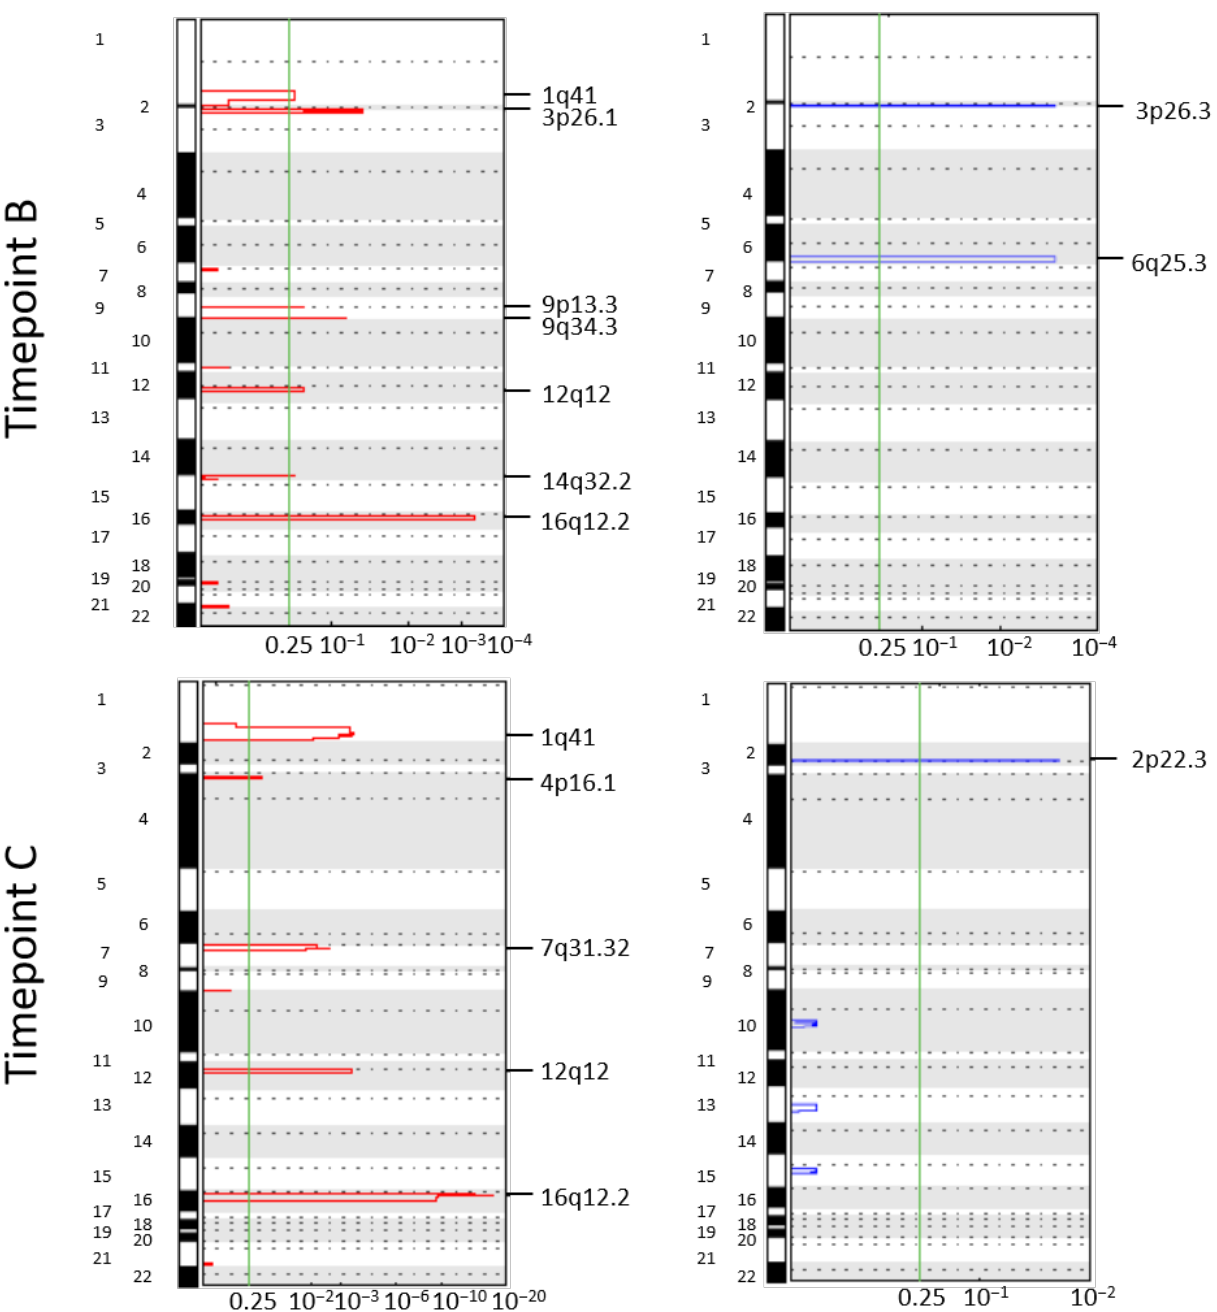
Figure 2. Genomic Identification of Significant Targets in Cancer (GISTIC) amplification and deletion plots on single circulating tumor cells (CTCs) from patient CH29. Each column represents a different timepoint. The genome is oriented vertically from top to bottom, and the GISTIC q-values at each locus are plotted from left to right on a log scale. The green line represents the significance threshold ( q -value = 0.25). A: basal (10 CTCs); B: screening (6–8 weeks after; 5 CTCs); C: end of therapy (13